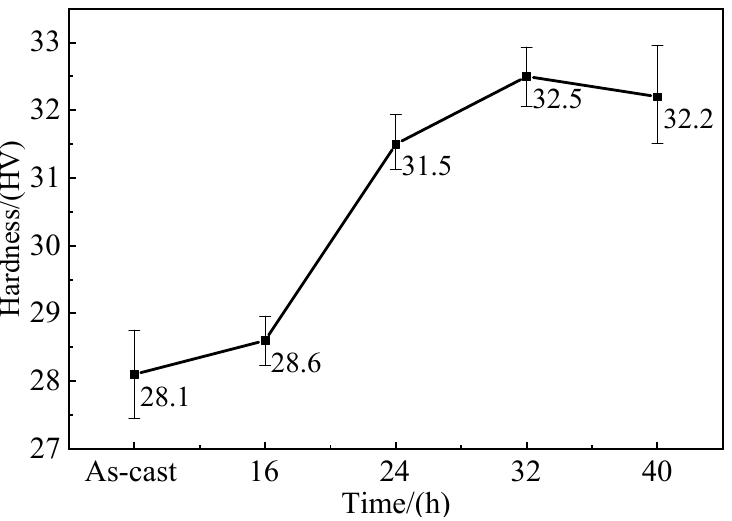
Figure 11. Microhardness of the alloy after treatment at 615 °C for different times.